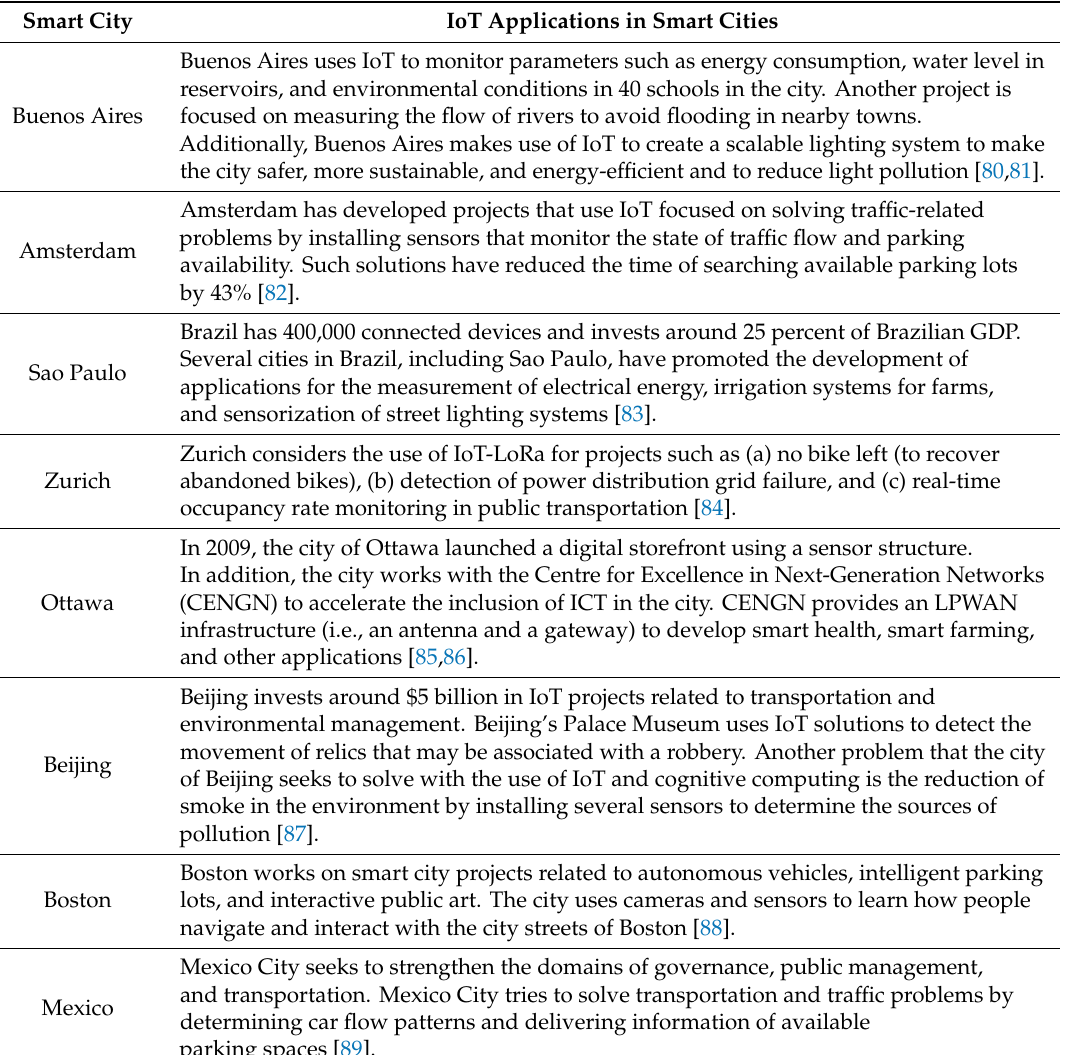
Table 13. Short description of IoT applications in smart